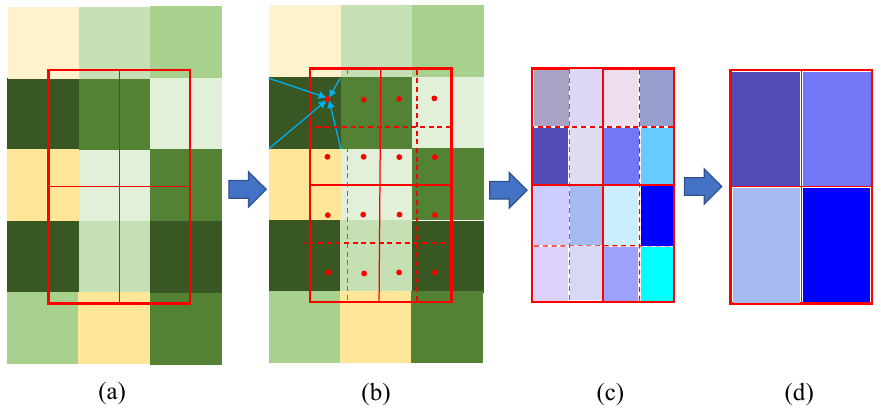
Figure 5. The procedure of RoIAlign. To begin with, the color grid represents a feature map and the red solid lines an RoI (with 2 × 2 bins) in ( a ). Then, in ( b ) sampling 4 points in each bin, which are demonstrated as the red dots. The value of each sampling point is computed by bilinear interpolation from the nearby grid points on the feature map, as the blue arrows pointed and the result is depicted in ( c ). Finally, max or average pooling is aggregated for 4 bins. The final feature after pooling is elucidated in ( d ).